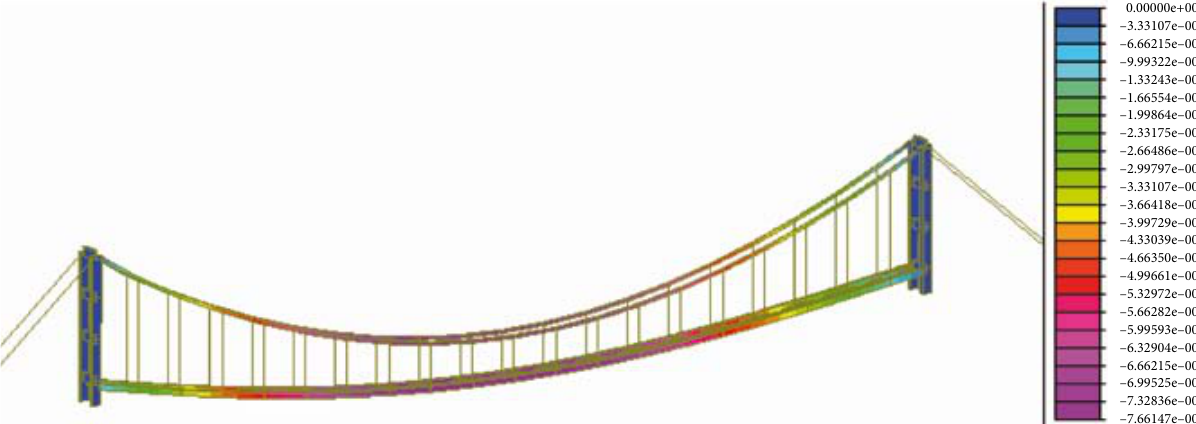
Fig. 5 . Deformed FEM of the bridge under symmetric loading (ξ = 0.6, γ = 1)